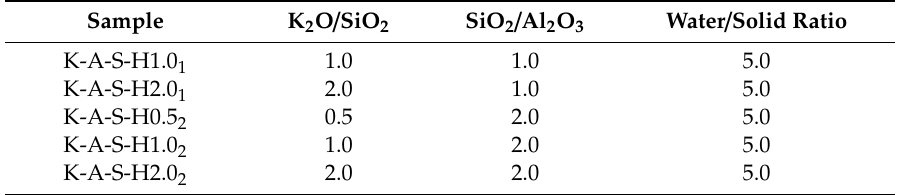
Table 1. Mixing proportions used to prepare K 2 O-Al 2 O 3 -SiO 2 -H 2 O